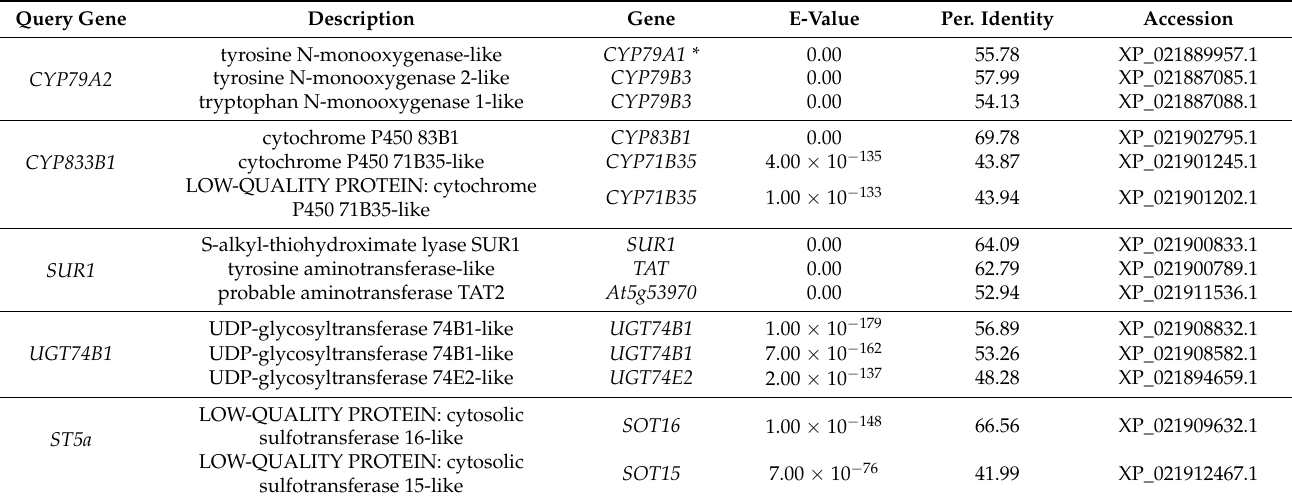
Table 2. Novel benzyl GSL biosynthetic genes identified in papaya using BLASTp.